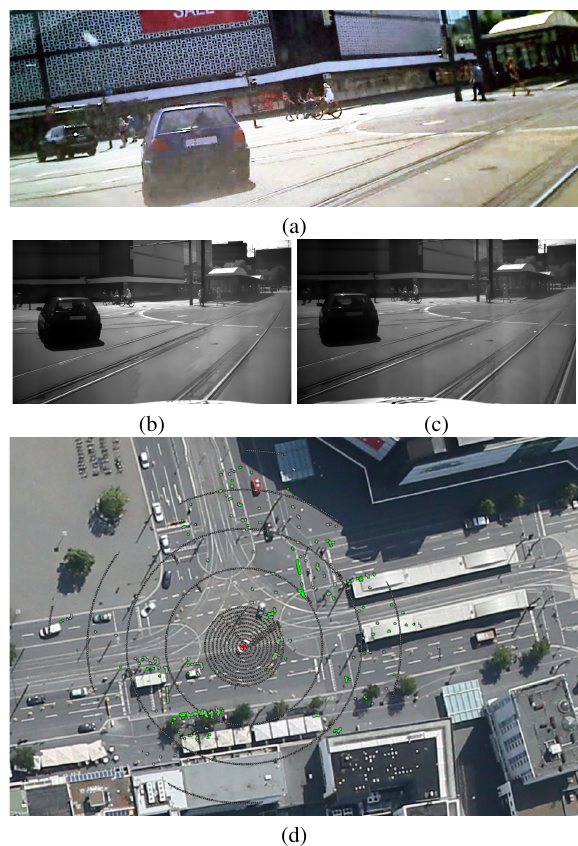
Figure 7. Screen shot from video (a) and image examples from stereo cameras left (b) resp. right (c) acquired from the FASCar reference vehicle. (d) shows the corresponding aerial image overlaid with LIDAR reflectance points (green dots) from the reference vehicle.